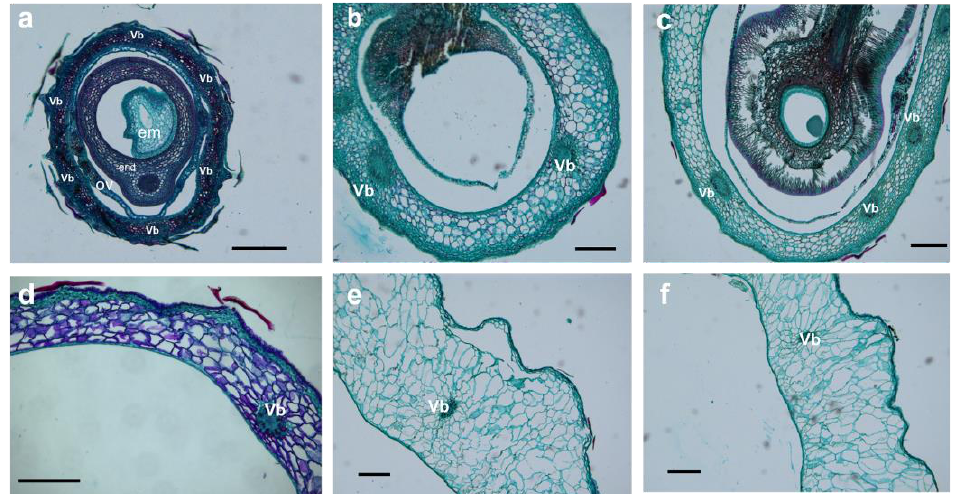
Figure 6. LM micrographs show transversal sections of H. rhamnoides ssp. sinensis fruit throughout six stages (10 DAA–120 DAA) of growth and development. ( a ) Cellular structure at 10 DAA. Six vascular bundles were arranged circularly on the side of mesocarp cells; ( b ) Cellular structure at 30 DAA; ( c ) Cellular structure at 50 DAA; ( d ) Cellular structure at 70 DAA; ( e ) Cellular structure at 90 DAA; ( f ) Cellular structure at 120 DAA. Bars = 250 µ m. Vb Vascular bundle; Ov Ovary; End endosperm; Em Embryo.